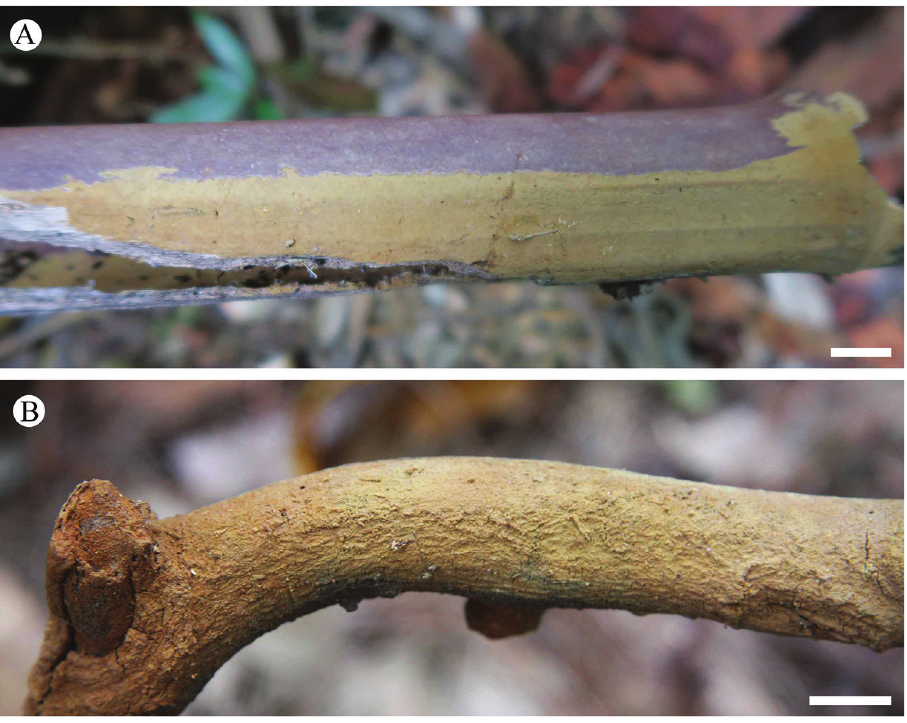
Figure 4. Basidiomes of Hymenochaete orientalis . A He 4601 (holotype) B He 1230. Scale bars: 1 cm. thick-walled, frequently branched at right angles, densely interwoven, agglutinated, 2.5–4 µm in diam. Setae abundant, subulate, bearing an acute tip, yellowish to reddish brown, arranged in 1–3 overlapping rows, usually with a hyphal sheath and a basal hyphal node composed of densely interwoven hyphae, without encrustations or slightly encrusted with age, 70–120 × 7–10 µm, projecting out of the hymenium up to 85 µm. Basidia clavate to subcylindrical, usually with a constriction in the middle part, some with walls thickening towards the base, colorless, with 4 sterigmata and a basal simple septum, 15–23 × 4–5.5 µm; basidioles similar to basidia but smaller. Basidiospores oblong-ellipsoid to cylindrical, with a small apiculus, colorless, thin-walled, smooth, sometimes with one or two small guttulae, 6–8(–8.5) × 3–3.8(–4) µm, L = 6.7 µm, W = 3.3 µm, Q = 2–2.1 (n =